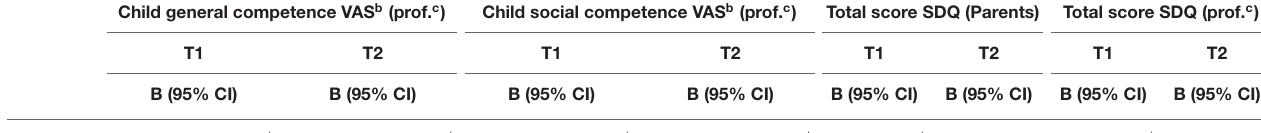
TABLE 6 | Linear regression analysis: association between PEDS concerns about expressive and receptive language development and child general competence, child social competence, and total score SDQ according to parents and professional caregivers at the age of 3 and 4 years; b- coefficient (B) and 95% confidence intervals (CI). Child general competence VAS b (prof. c )